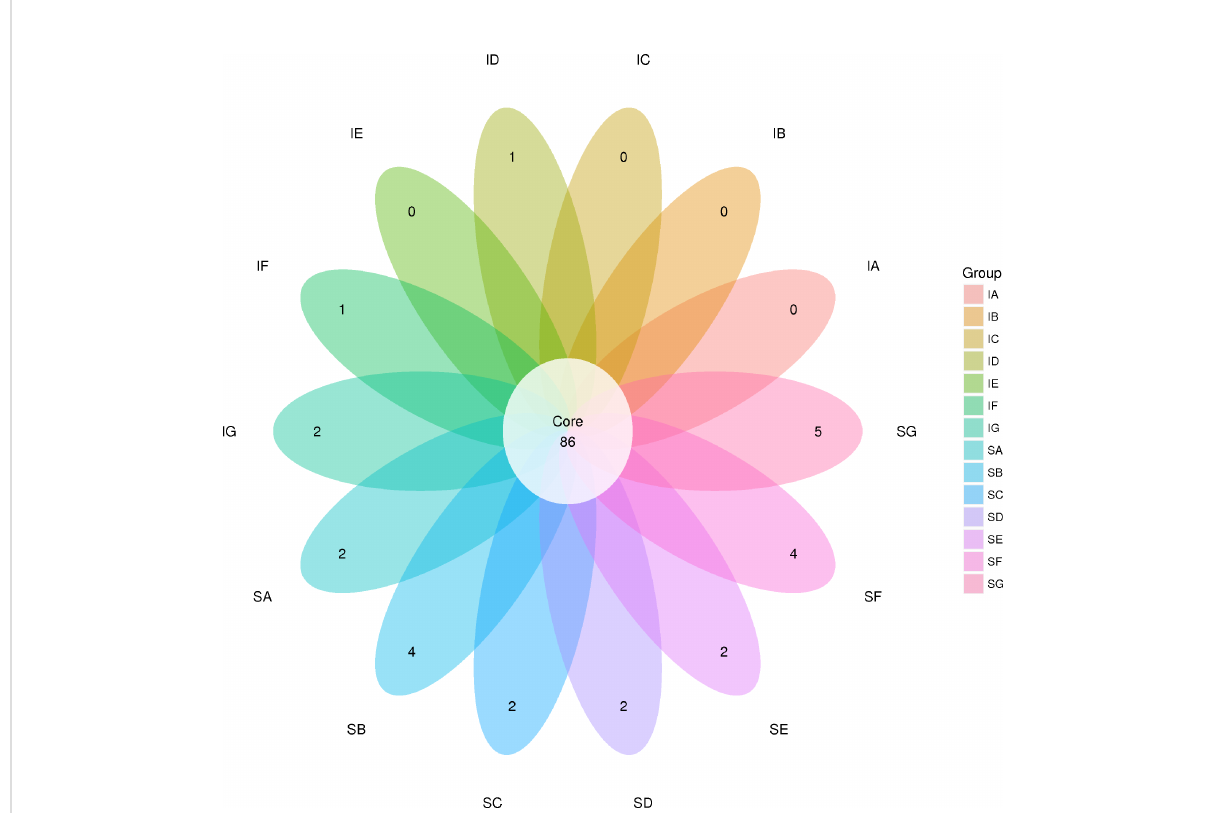
FIGURE 1 Venn diagram showing the numbers of shared operational taxonomic units (OTUs) among samples (the numbers in overlaps of the diagram indicate shared OTUs that were detected in at least 50% of samples in each of two or more samples). SA, control; SB, CpGui10; SC, CpGui15; SD, CpGui20; SE, CpP10; SF, CpP15; SG, CpP20; IA, control; IB, CpGui10; IC, CpGui15; ID, CpGui20; IE, CpP10; IF, CpP15; IG,